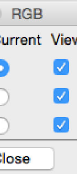
Fig. 40.— The RGB popup menu With the “red” option checked, go to “file” in the main menu and “open” in the submenu and load hst 05773 05 wfpc2 f673n wf drz.fits. Next, check green and load hst 05773 05 wfpc2 f656n wf drz.fits. You should already see a superposition of the red and green parts at this stage. Finally, check blue and load hst 05773 05 wfpc2 f502n wf drz.fits. There is your